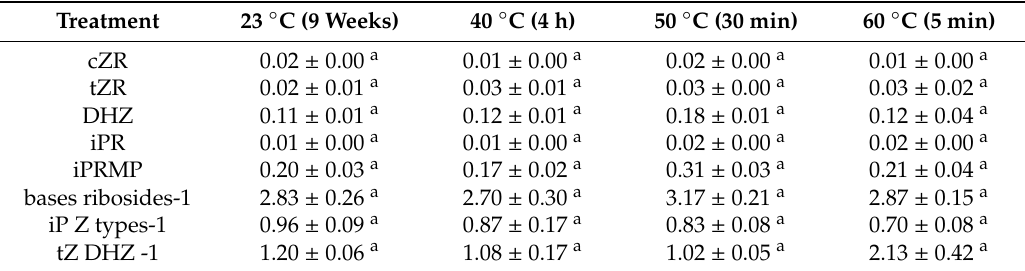
Table 6. Concentration of endogenous isoprenoid cytokinins (pmol g −1 FW) of P. halepensis embryogenic masses collected at the end of initiation phase and induced under different temperatures. bases